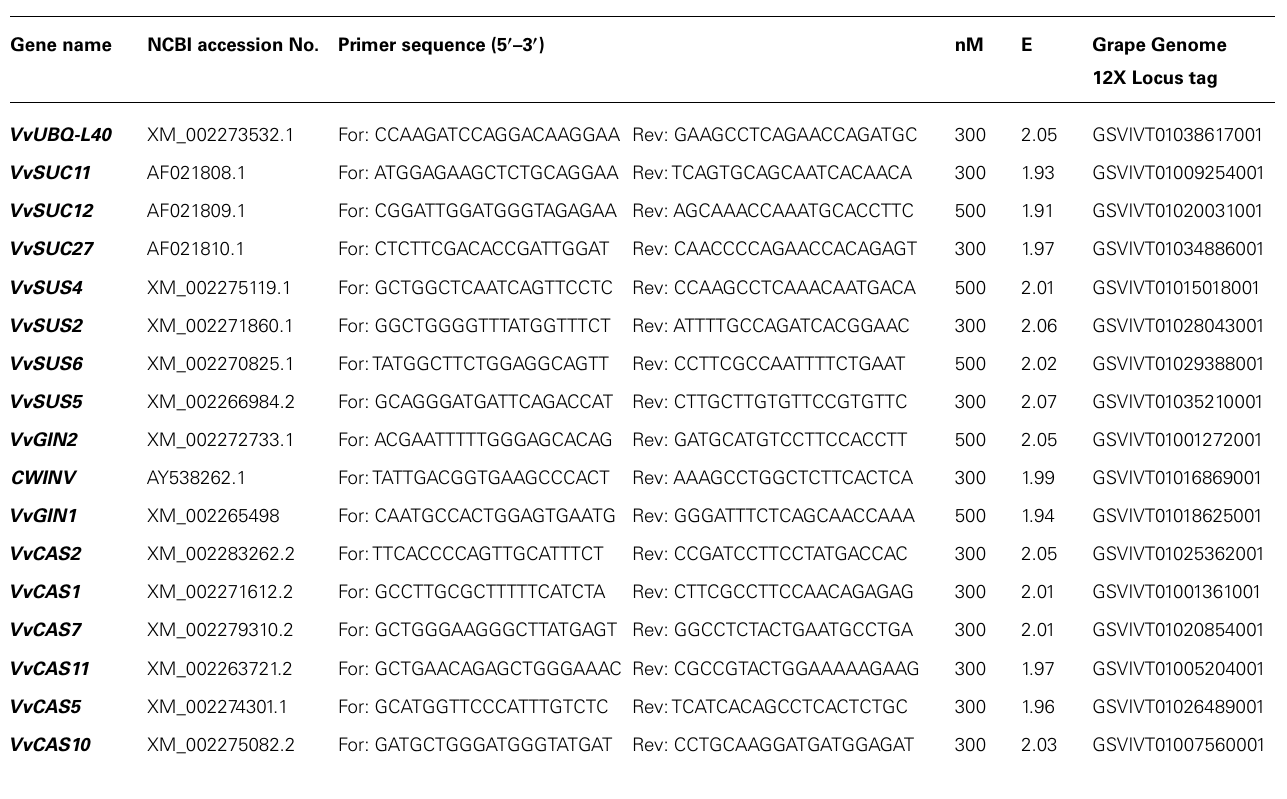
Table 1 |Accession number of sequences and primers used for real-time